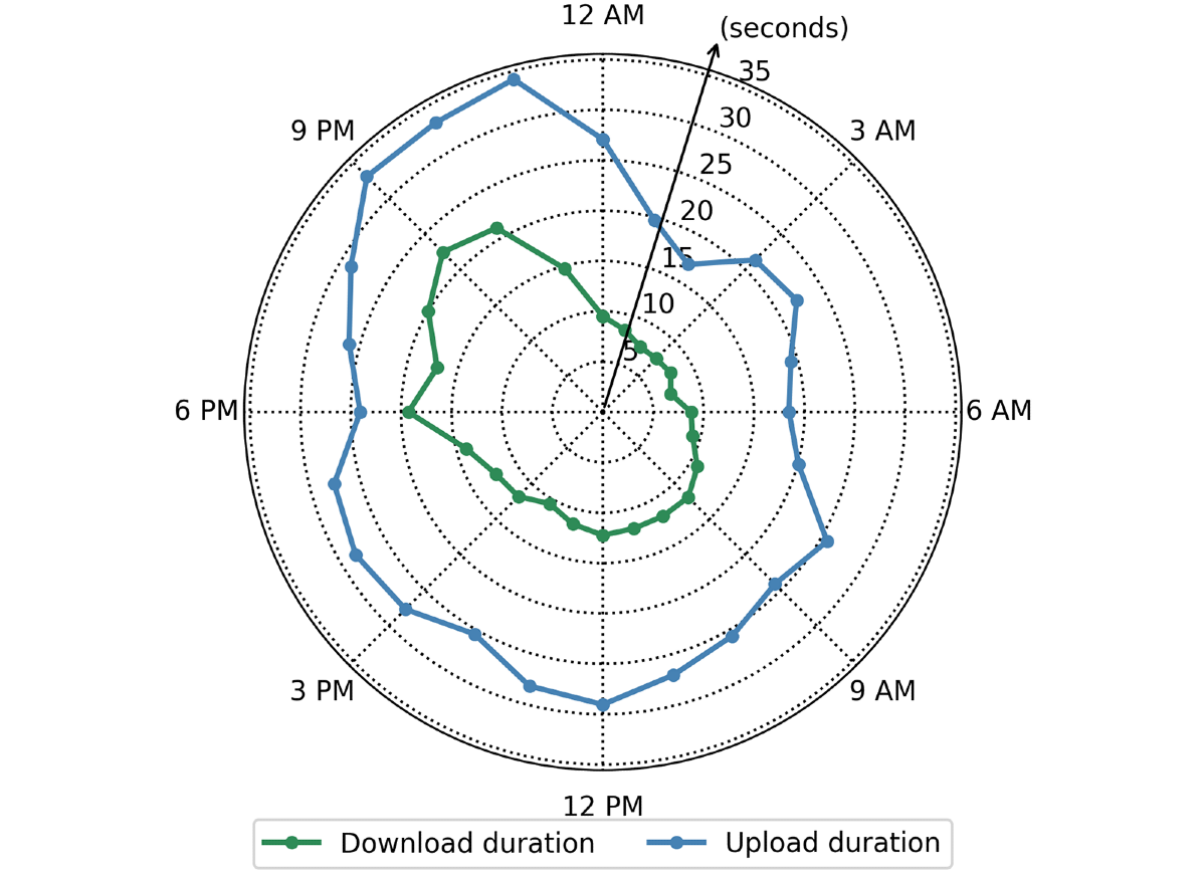
Figure 8. Average download and upload durations for each hour of the